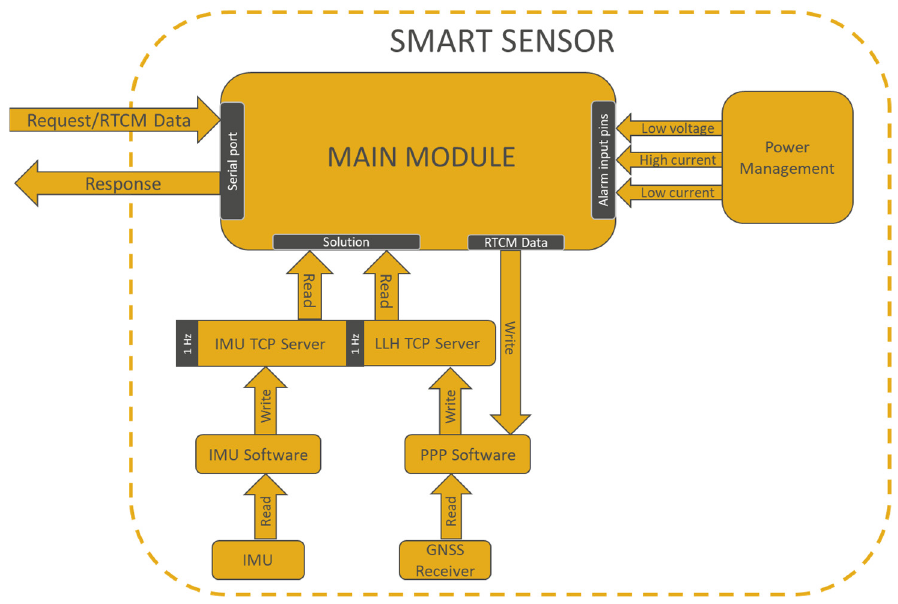
Figure 4. Smart sensor data flow.